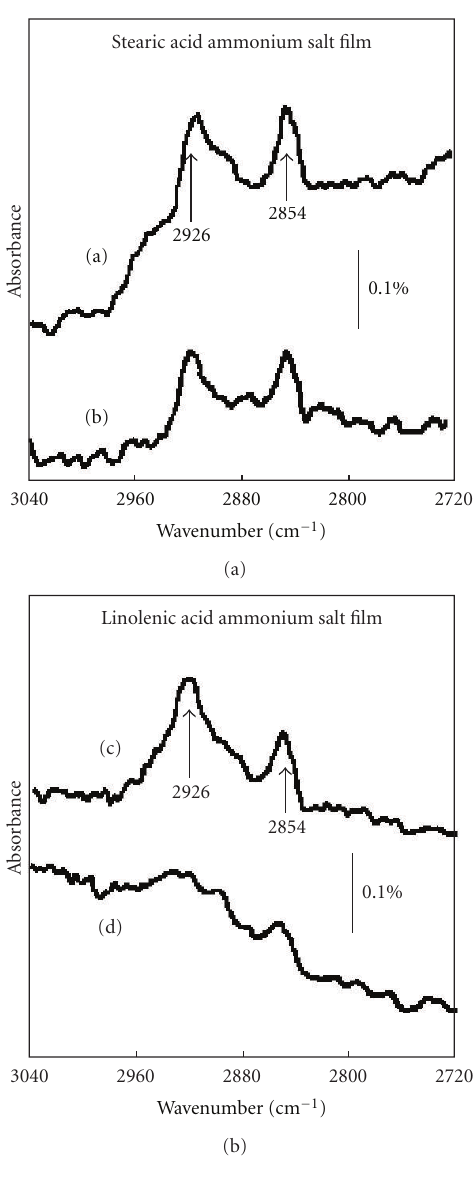
Figure 17: FTIR spectra of before and after the test. (a) RAS of stearic acid ammonium salt film, (b) RAS of film after the test. (c) RAS of linolenic acid ammonium salt film, (d) RAS of film after the test.